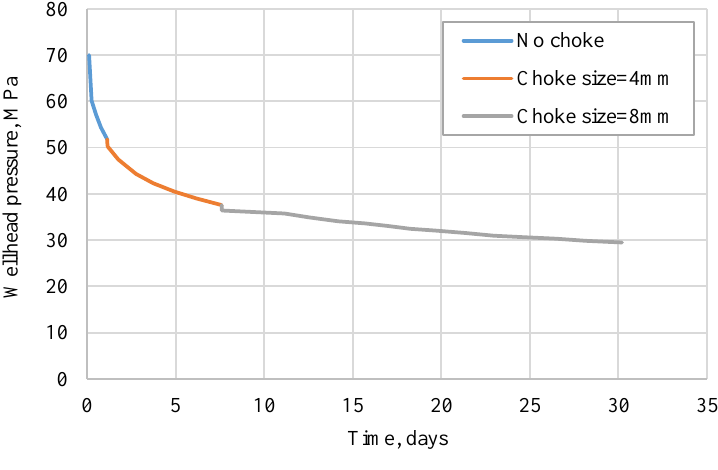
Figure 13—Wellhead pressure in natural fracture closure